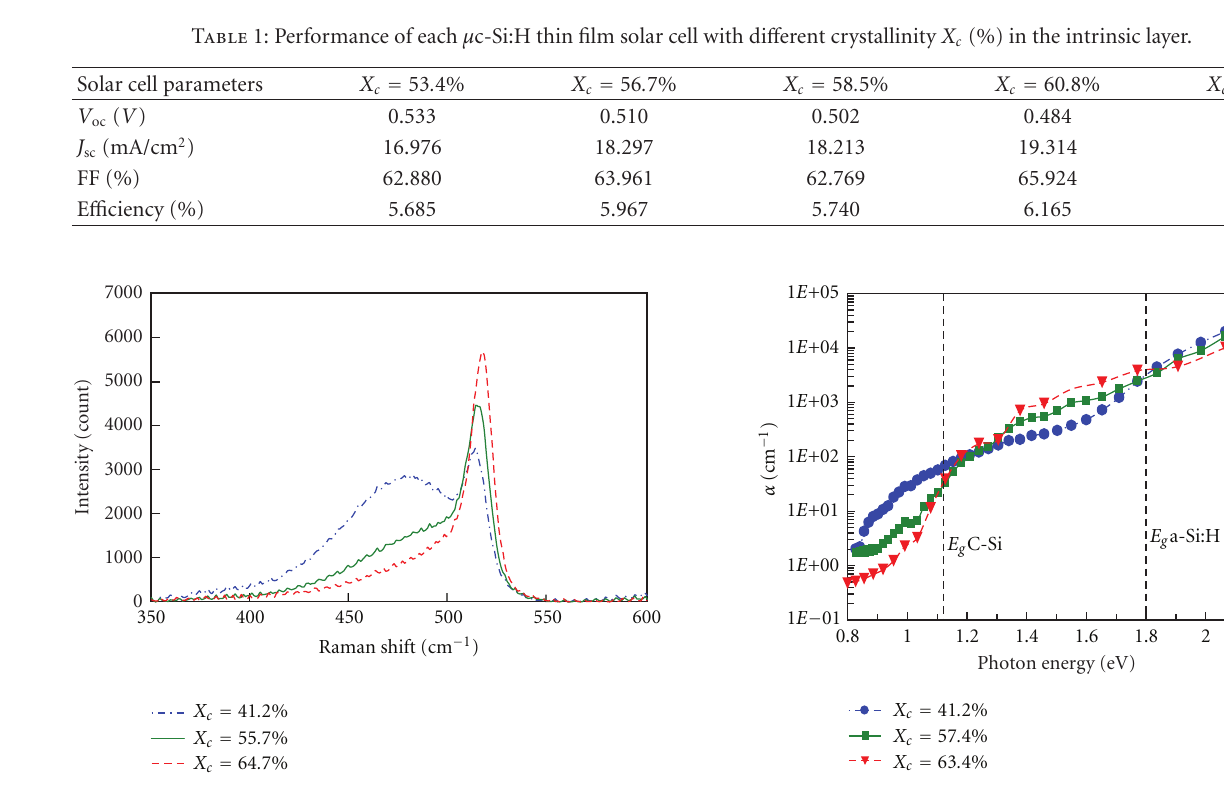
Figure 2: Absorption coe ffi cients of μ c-Si:H thin films with di ff erent crystalline volume